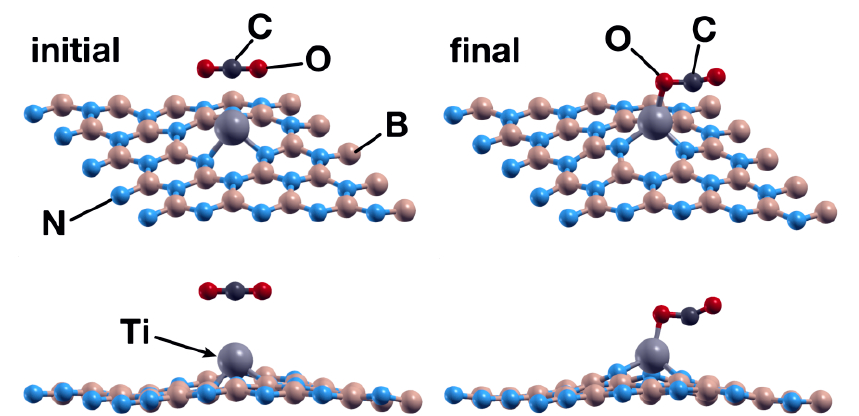
Figure 6. Initial ( left ) and final ( right ) configurations for the interaction of the hBN surface with a Ti absorbed in a B vacancy and a CO 2 molecule. As in Figure 4, the upper row shows a system’s perspective, while the lower one presents the XZ plane. The titanium atom acts as a catalyst to chemisorb the CO 2 molecule in the system.